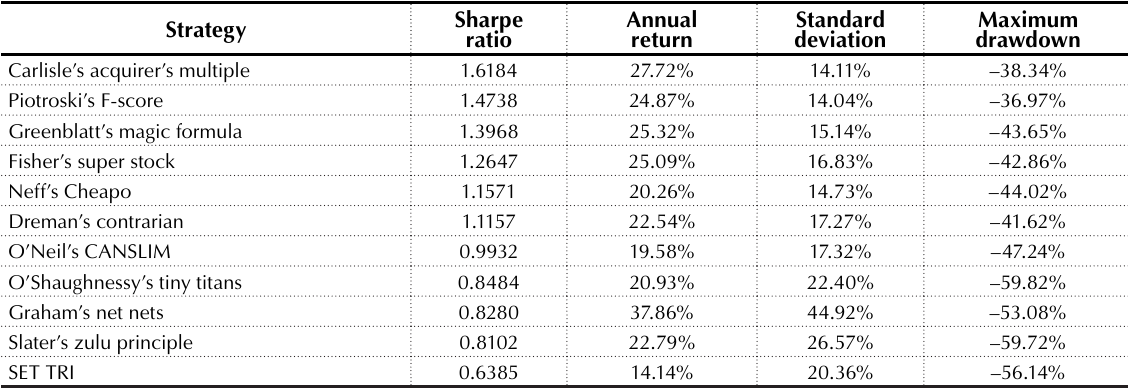
Table 4. Risk and return for all 10 portfolios over 14